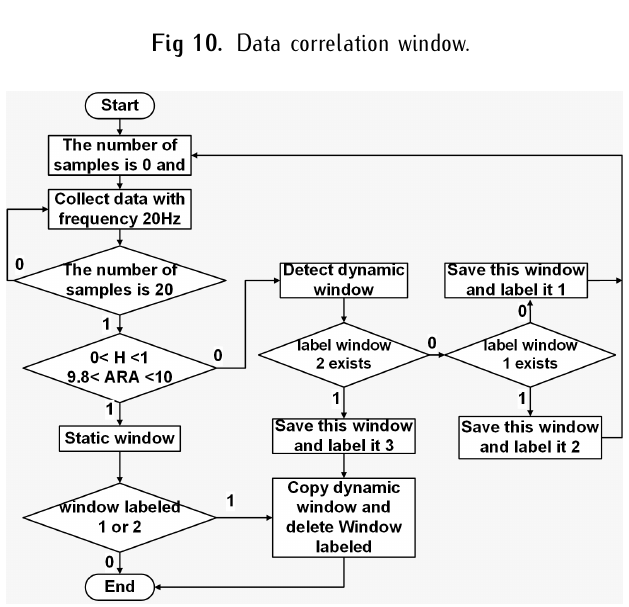
Fig 11. After analyzing every second of data for signal changes, the algorithm identified dynamic windows after 1–3